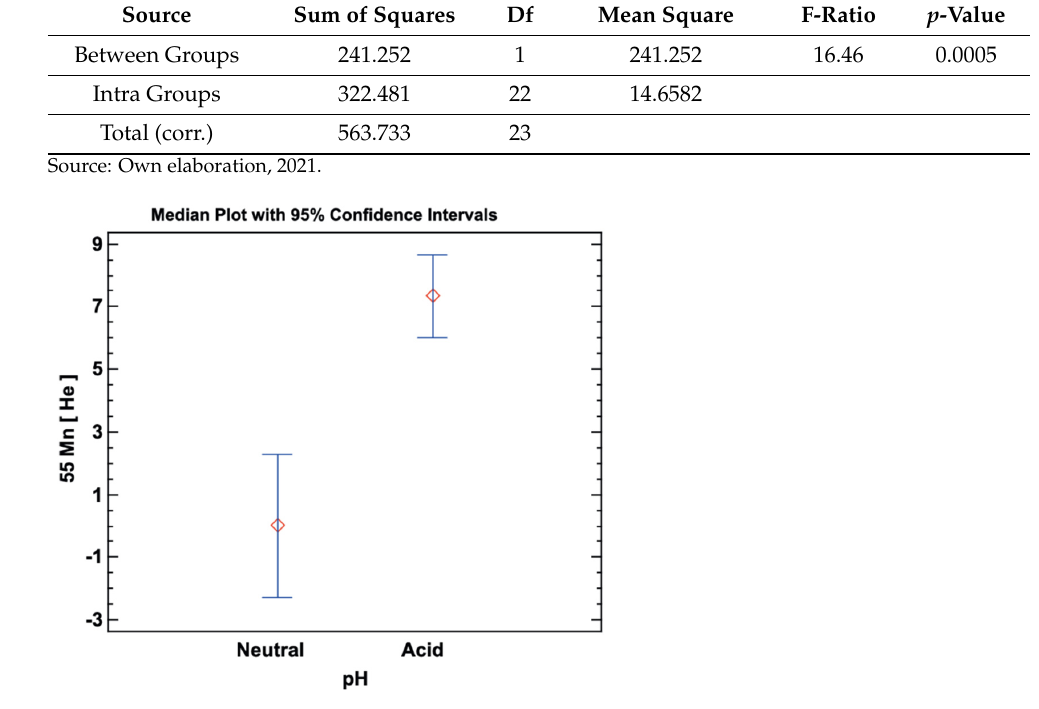
Figure 8. Graph means with LSD Fisher 95% confidence intervals, for the effect of the pH value with the concentration of Manganese (Mn).